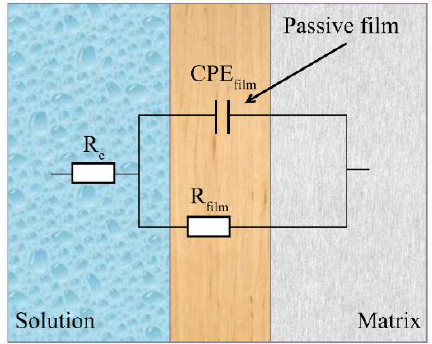
Figure 7. Equivalent circuits used for fitting the experimental impedance data.